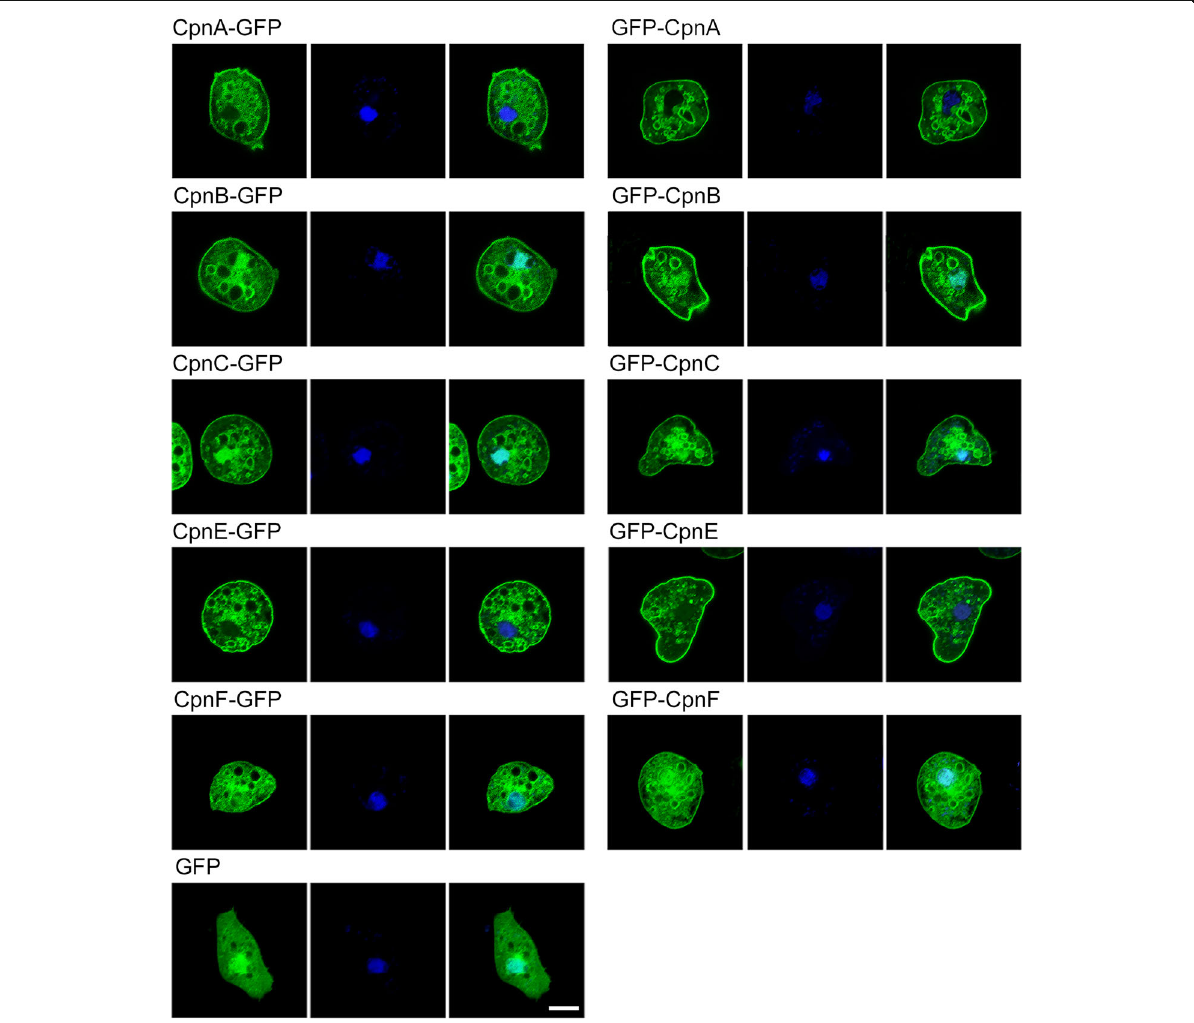
Fig. 1 Localization of GFP-tagged copine proteins in fixed cells. Cells expressing GFP or a GFP-tagged copine were fixed in 1% formaldehyde in cold methanol and stained with 0.1 μ g/ml DAPI. Three images of a representative cell from each cell line are shown. The first image shows the GFP fluorescence, the second shows the DAPI staining, and the third is a merged image showing both GFP and DAPI. Images were obtained with a Nikon Eclipse Ti inverted laser scanning confocal microscope using a 60× oil immersion objective. Scale bar = 5 μ